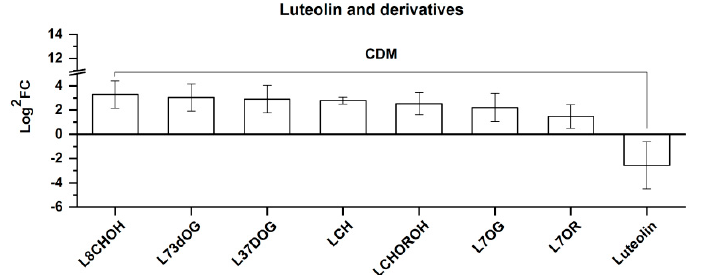
Figure 7. Comparison of eight CDMs of luteolin and its derivatives between SJL and SN. Upregulation denotes that the content of a metabolite increased in SN compared with that in SJL, and the opposite for downregulation. The Y -axis is exhibited as Log 2 FC values for the convenience of visual presentation, and the X -axis denotes the metabolite names. Abbreviation: L8CHOH, luteolin 8- C -hexosyl- O -hexoside; L73dOG, luteolin 7,3 ′ -di- O -glucuronide; L37DOG, luteolin 3 ′ ,7-di- O -glucoside; LCH, luteolin C -hexoside; LCHOROH, luteolin C -hexosyl- O -rhamnoside O -hexoside; L7OG, luteolin-7- O -glucoside; L7OR, luteolin-7- O -rutinoside.